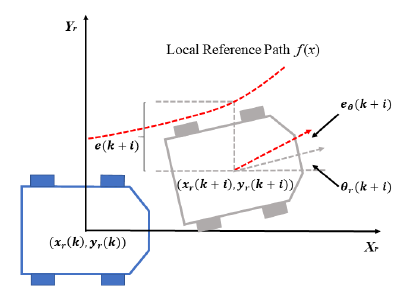
Figure 6. The definition of tracking error and yaw